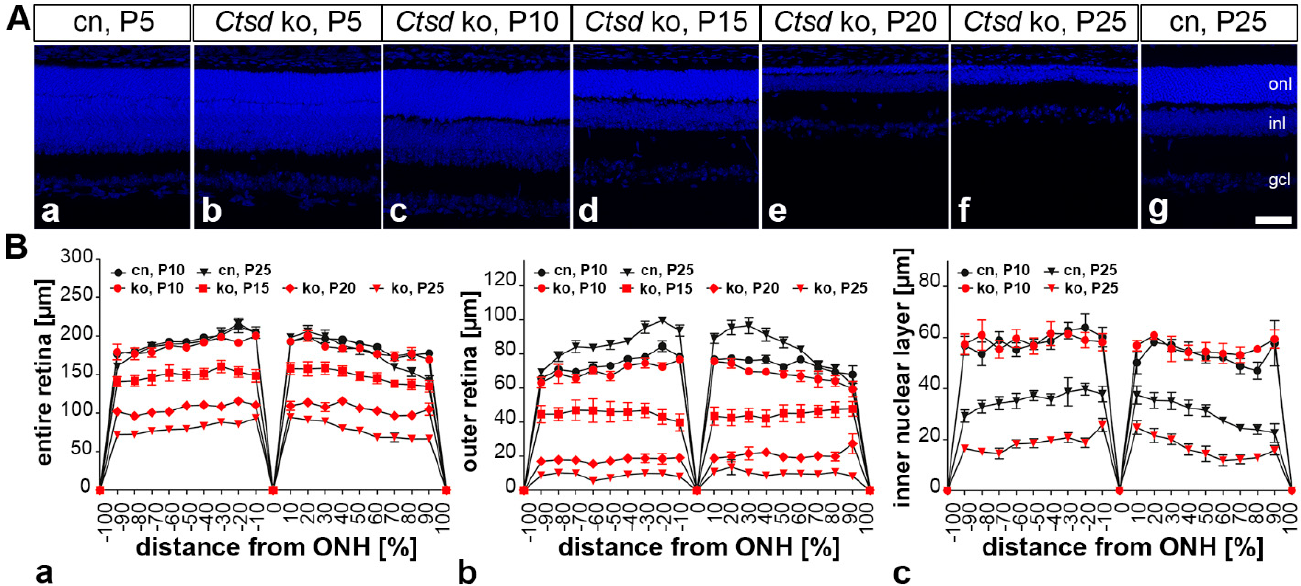
Figure 1. Progressive thinning of the Ctsd ko retina. ( A ) Retina sections from Ctsd ko mice at different ages ( b – f ) demonstrate a rapidly progressing retinal dystrophy in the mutant. Retinas from 5- ( a ) and 25-day-old control mice ( g ) are shown for comparison. ( B ) Quantitative analyses revealed no significant thinning of the entire retina ( Ba ), outer retina ( Bb ) or inner nuclear layer ( Bc ) in 10-day-old Ctsd ko mice when compared with age-matched control mice. Significant thinning of the entire retina ( Ba ), outer retina ( Bb ) and inner nuclear layer became apparent in 15-day-old Ctsd ko mice and further progressed with increasing age of the mutants (i.e., P20 and P25). For reasons of clarity, only data for selected ages are shown in ( B ). cn, control; gcl, ganglion cell layer; inl, inner nuclear layer; ko, knock-out; ONH, optic nerve head; onl, outer nuclear layer; P, postnatal day. Scale bar: 50 µm.